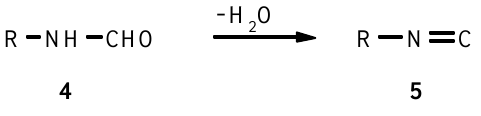
Scheme 3: General synthesis of